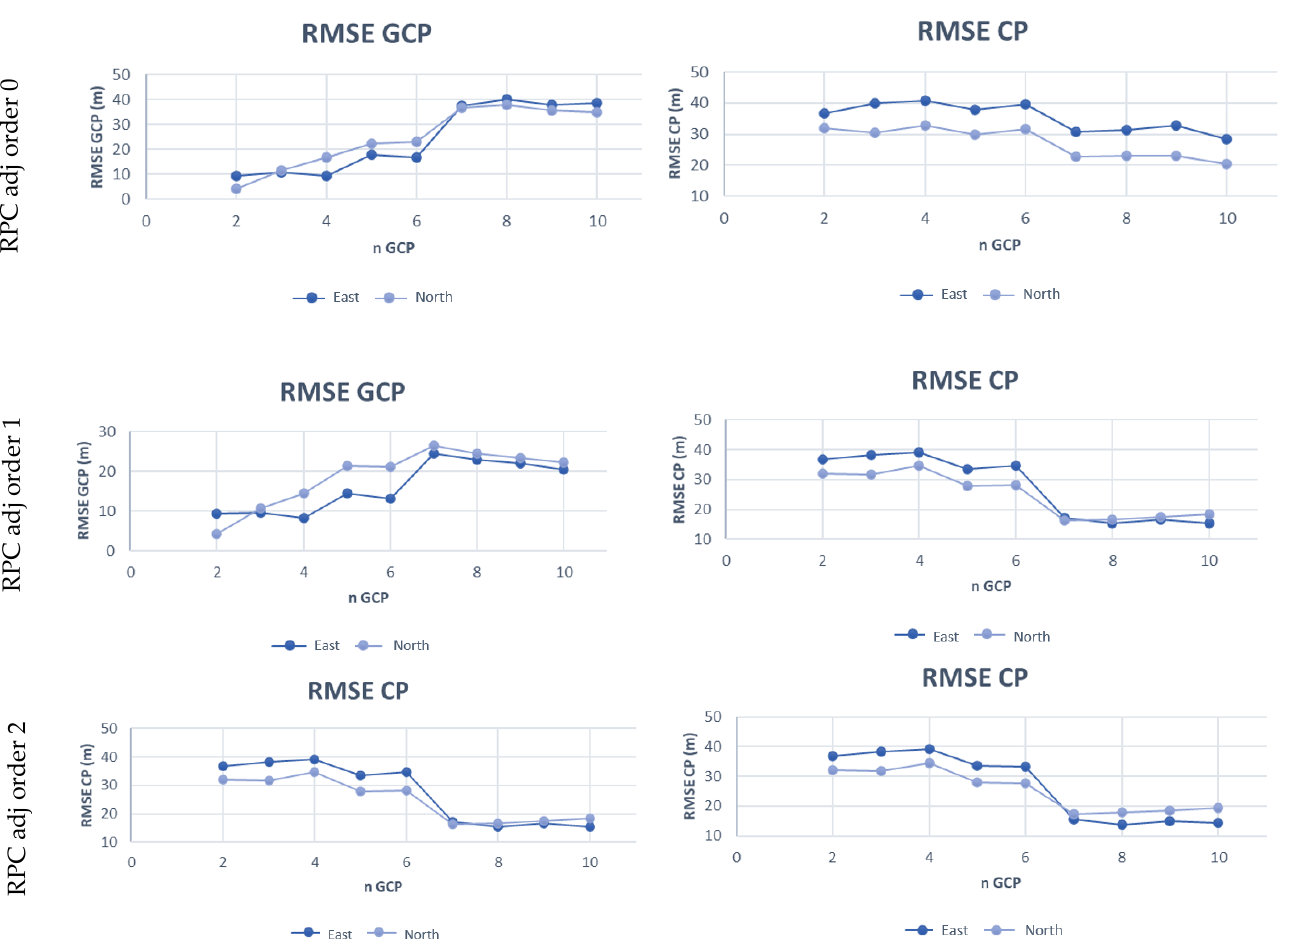
Figure 7. Precision and accuracy trends for Fucino image.